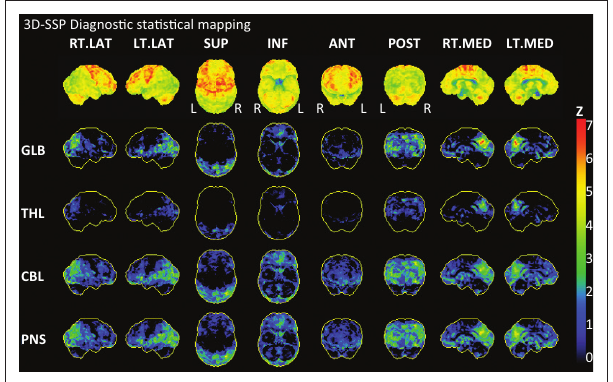
FIGURE 2: Example of a single-subject statistical analysis (decreases) for a FDG PET scan of a patient with dementia with Lewy Bodies. The top row represents surface projections of both brain hemispheres from different angles. Subsequent rows represent negative deviations from the normal database mean (z-score) for all brain regions, normalised to global counts (GLB), thalamus (THL), cerebellum (CBL), and pons (PNS). Similar outputs are generated for statistical increases (not shown). In this example, reduced metabolism in bilateral parietal occipital vortices is evident. Such analyses are highly recommended to support the interpretation of brain